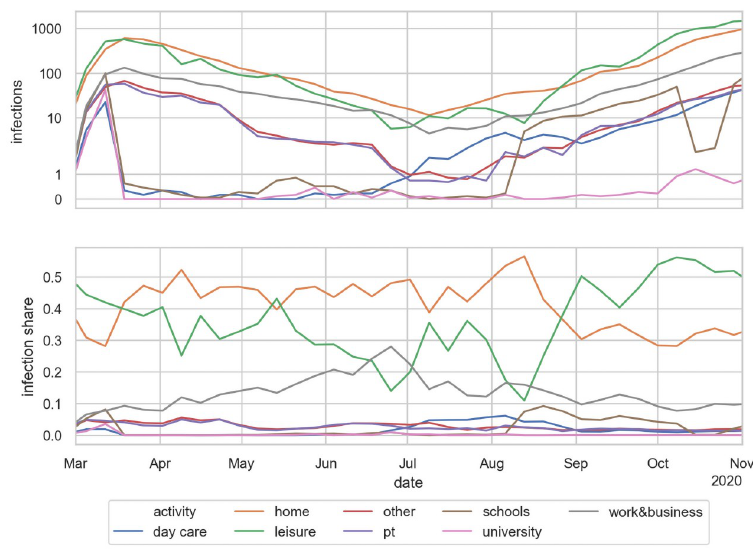
Fig 13. Infections per activity type. TOP: absolute numbers. Note logarithmic scale. BOTTOM: Share of infections per activity type. The values are averaged over the same 10 runs as for the other figures, and in addition aggregated into weekly bins. One can see, for example, the return to school near the beginning of August, and the fall vacations in October.